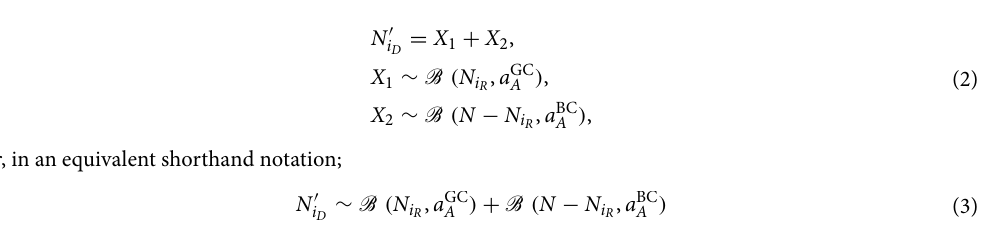
or, in an equivalent shorthand notation;